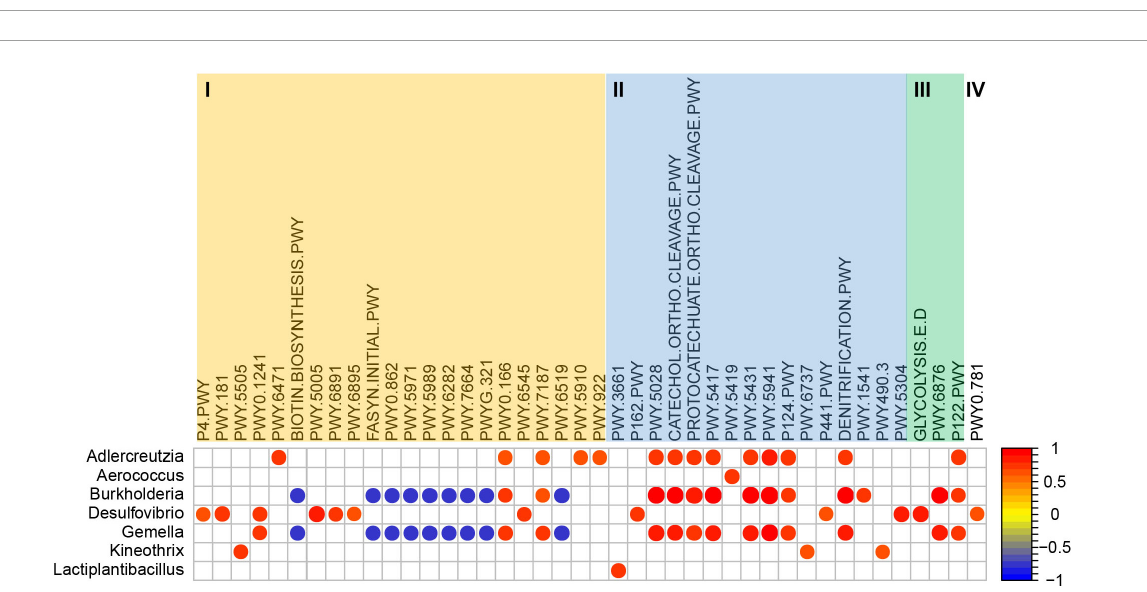
FIGURE4 The biological network of gut microbiota in mice. (A) Network analysis showed co-occurrence among gut microbes in mice. Each node represents a genus of bacteria, and the size of the node is proportional to the relative abundance of that organism in the microbial community. The different color in the circles indicate the proportion of the relative abundance of the genus among the four groups. Red and black lines between nodes imply a positive and negative relationship between bacteria, respectively. (B) Network analysis showed co-occurrence between Lactiplantibacillus and other gut microbes in mice. Each node represents a genus of bacteria with the color indicating the phylum to which the genus belongs. The size of the node is proportional to the relative abundance of that organism in the microbial community. Red and green lines between nodes imply a positive and negative relationship between bacteria, respectively. Only taxa with correlation significance less than 0.05 are shown.